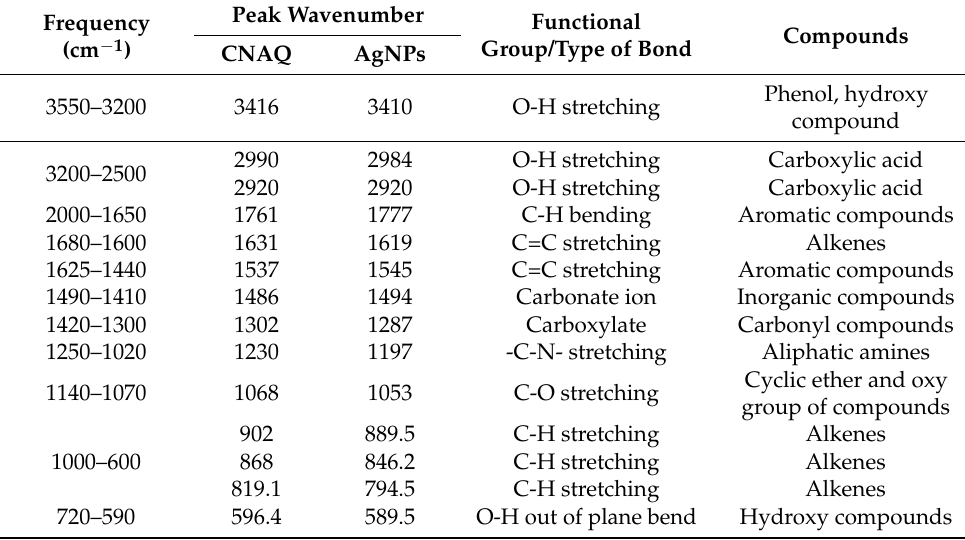
Table 1. FTIR profiling of CNAQ and